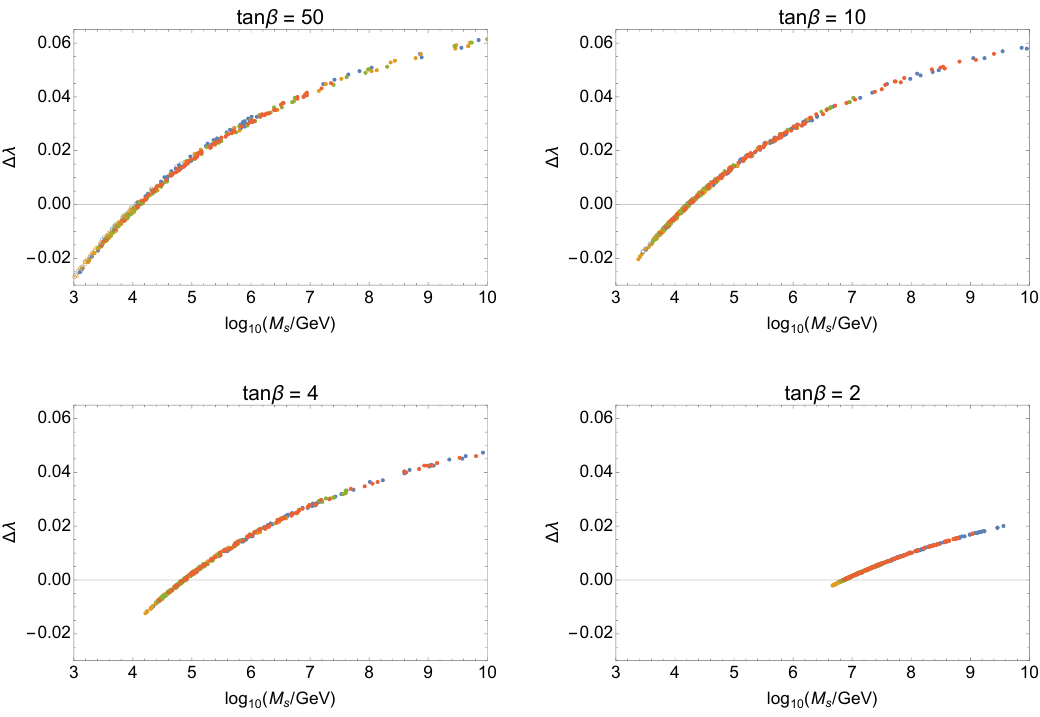
Figure 3 . Same as (cid:12)gure 1, now showing SUSY threshold correction for the Higgs quartic coupling, de(cid:12)ned as (cid:1) (cid:21) (cid:17) (cid:21) (cid:0) (cid:21) e(cid:11) at the matching scale (cid:3) = M s . see eqs. (3.44) and (3.45). The dependence on x